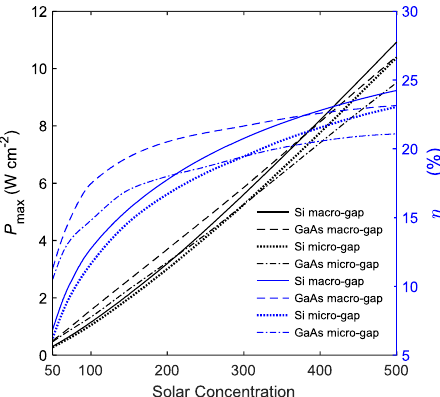
Fig. 7 Performance comparison between different thermionic device con fi gurations. At each solar concentration ratio, the data are shown at MPP, and the optimal interelectrode gap width was chosen for the micro- gap devices. For macro-gap devices, the interelectrode gap width is of the order of